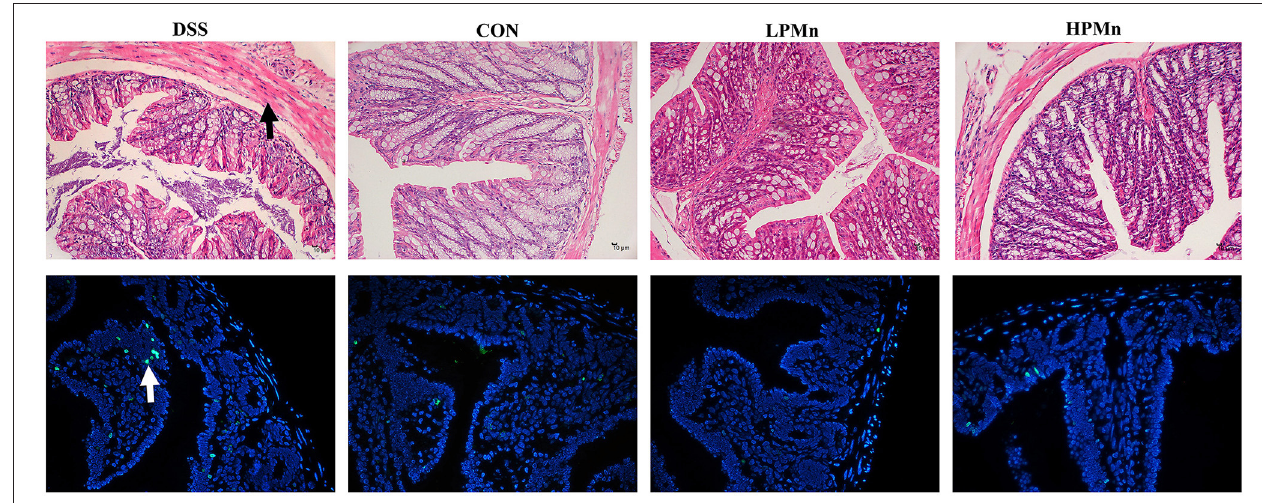
FIGURE 3 | Ulva polysaccharide-manganese improved histopathological damage and apoptosis. Upper, representative images of HE staining results (Arrow, morphology damage); Lower, representative images of TUNEL staining results (Arrow, apoptosis cells).